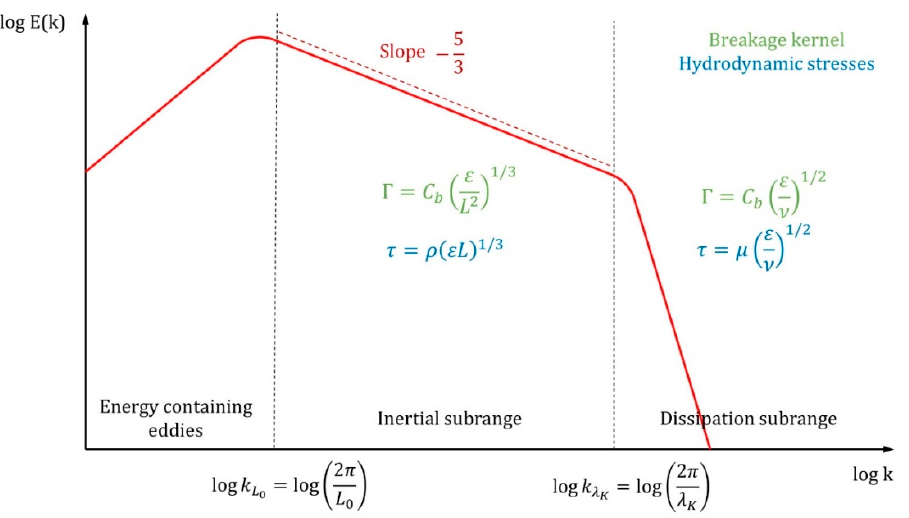
Figure 6. Illustration of breakage function based on turbulence spectrum.